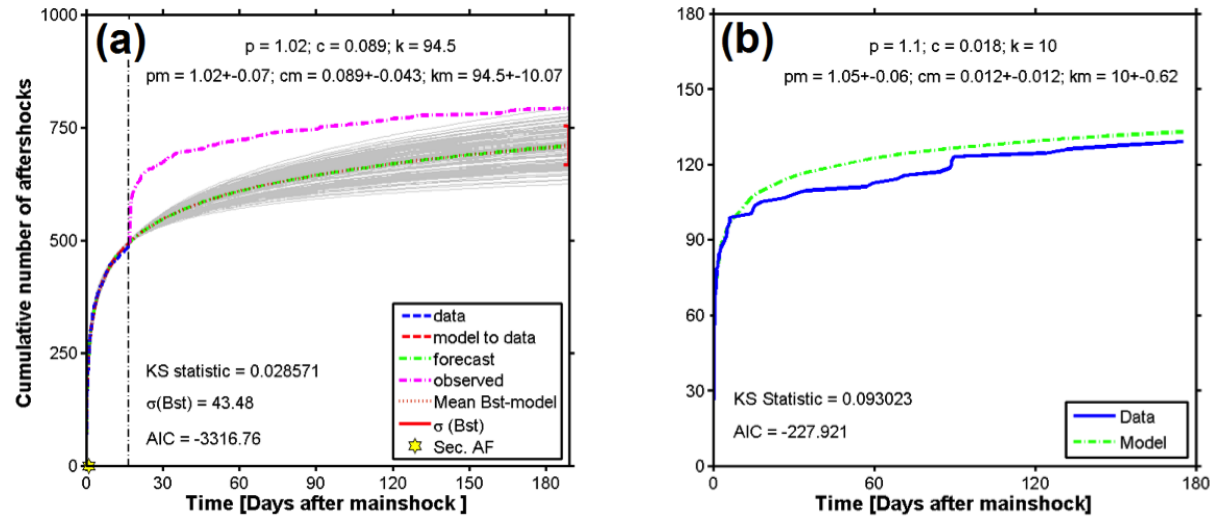
Figure 2. ( a ) The calculated model parameters and the forecast model of aftershocks activity for Nepal earthquake sequence based on ob- served data of 17 days learning period ( t ), estimated using maximum likelihood method. The bootstrap forecast models plotted as gray lines L in the background fit with the modified Omori law. The brown line depicts the mean forecast model whereas the red bar shows the stan- ). p , c and K indicates the modified Omori’s parameters of the forecast model (green dard deviation of forecasted events at forecasted time ( t F line) whereas pm , cm and km shows the modified Omori’s parameters of the mean forecast model (brown line). The value of the standard deviation of the bootstrap model ((Bst)) is estimated to be 43.48. The vertical line indicates the end of the learning period. Star at time axis depicts the largest aftershock in learning period which is used to segregates the learning period in two time spans to fit the modified Omori’s model parameters. ( b ) Observed cumulative number of aftershocks of the May 12 earthquake (a solid line) and the evaluated curve of the modified Omori formula fitted to the aftershock data during the period May 12 - October 31, 2015 (a broken